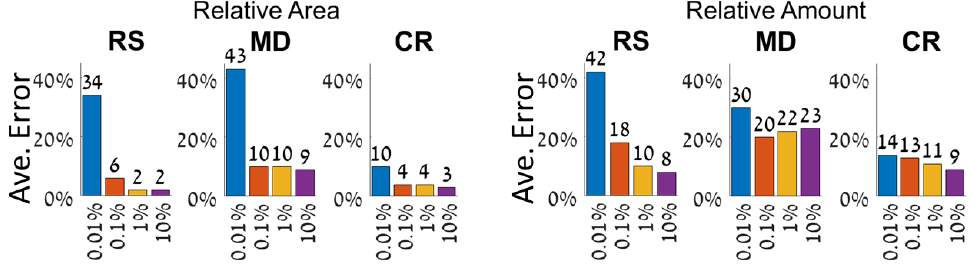
Figure 9. Percent average error in relative area and relative amount over eight classes in the different data-sets. In relative area ( left ), the error values are low and there is no significant decrease in error above sparsity 0.1%. The error for sparsities 0.1–10% ranges from two to ten %. In relative amount ( right ), there is a decrease in error above sparsity 0.1% in the RS and CR data-sets, but not in the MD data-set. The error for sparsities 0.1–10% ranges from eight to